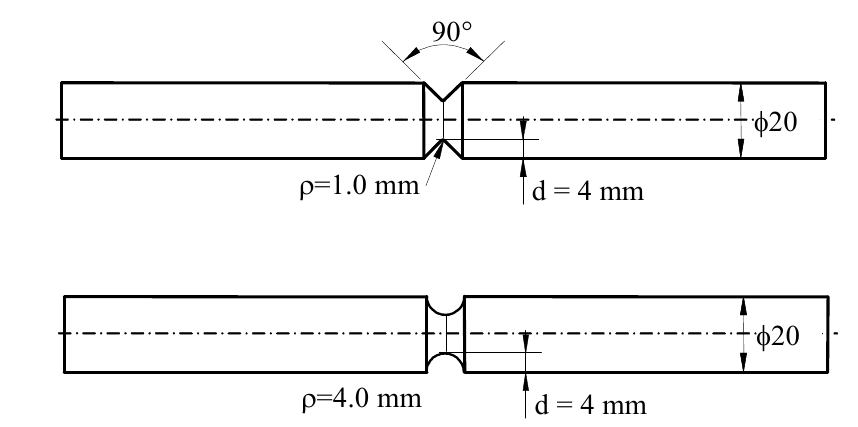
Figure 1: Geometry of V-notched specimens and semicircular